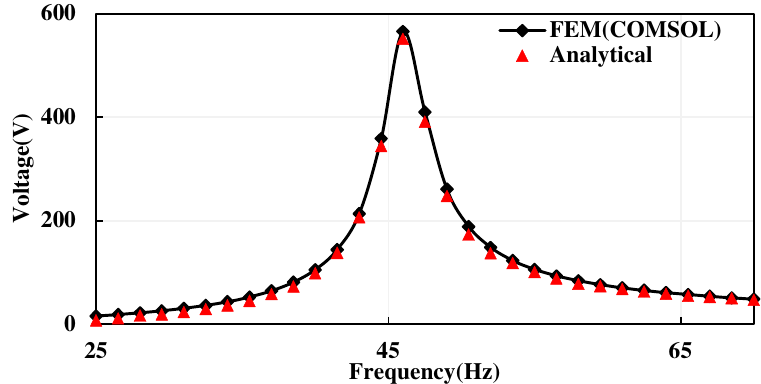
Figure 7. Voltage responses of the FEM model and the analytical model. Table 4. Material and geometric parameters of the harvester utilized for analytical validation [40].